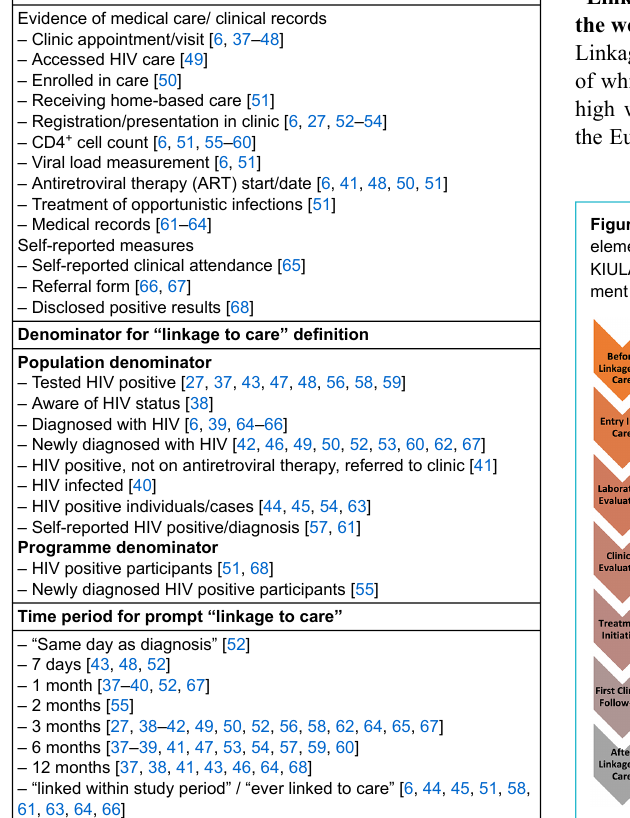
Table 2: “Linkage to care” definitions in literature from sub-Saharan Africa: summary of numerators, denominators and time periods. Numerator for “linkage to care” definition